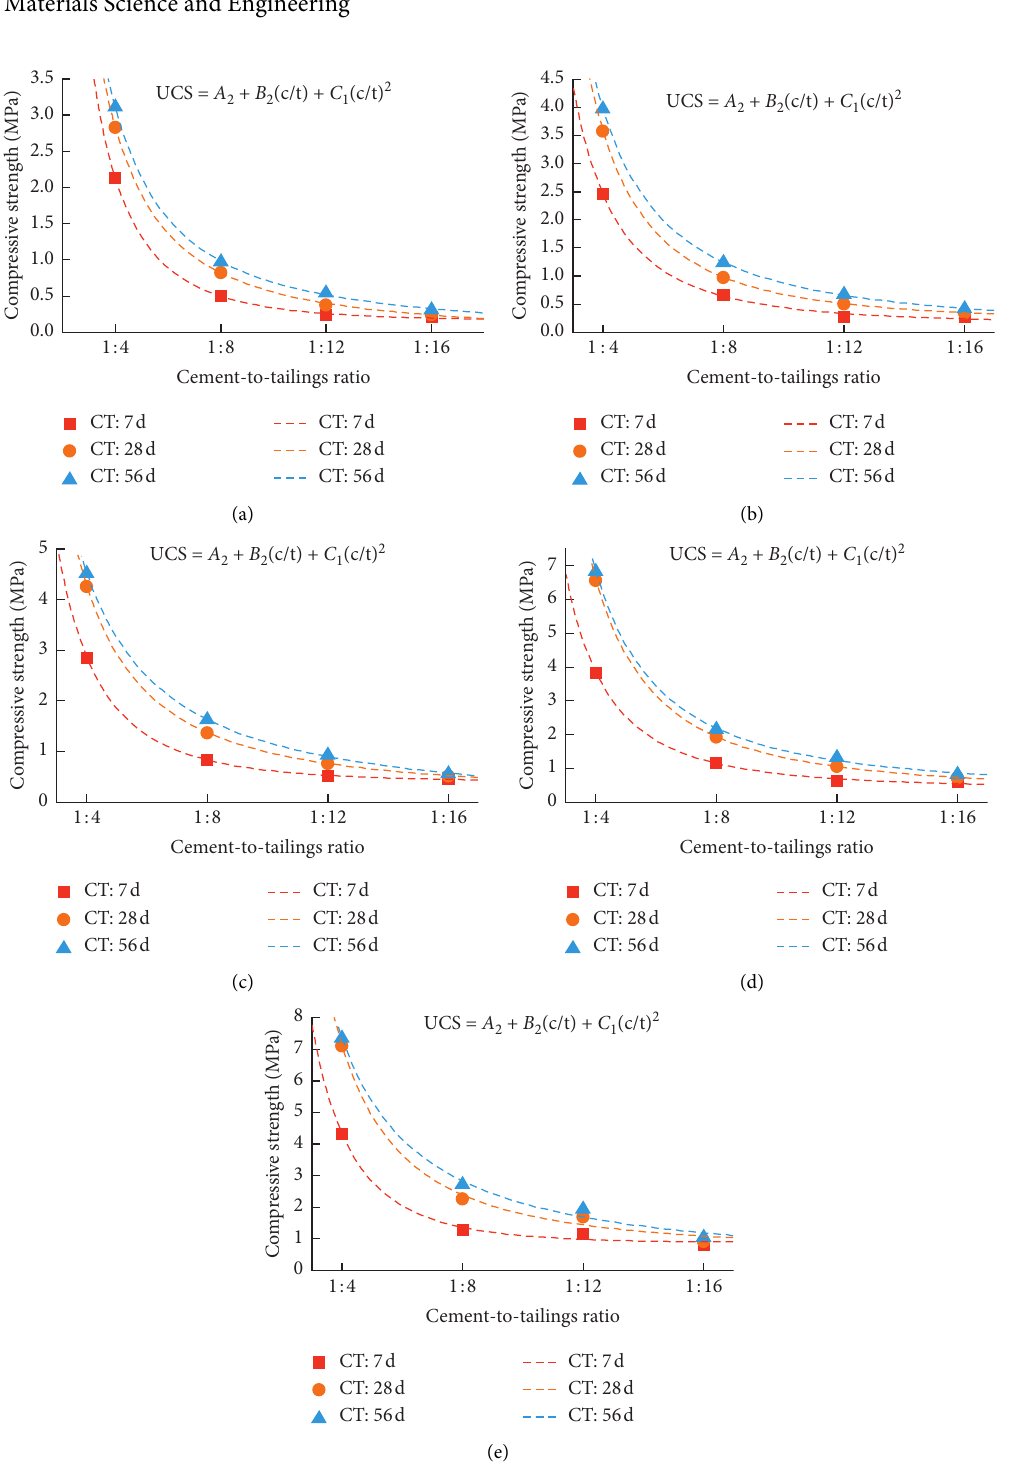
Figure 8: Relationship between c/t and UCS of CUTB: (a) SD: 72%; (b) SD :74%; (c) SD: 76%; (d) SD :78%; (e) SD: